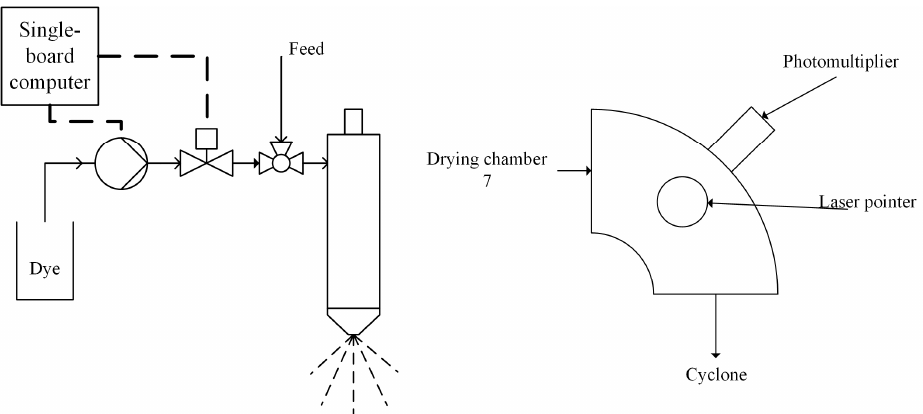
Figure 4. Schematic diagram of the RTD measurement devices [22].